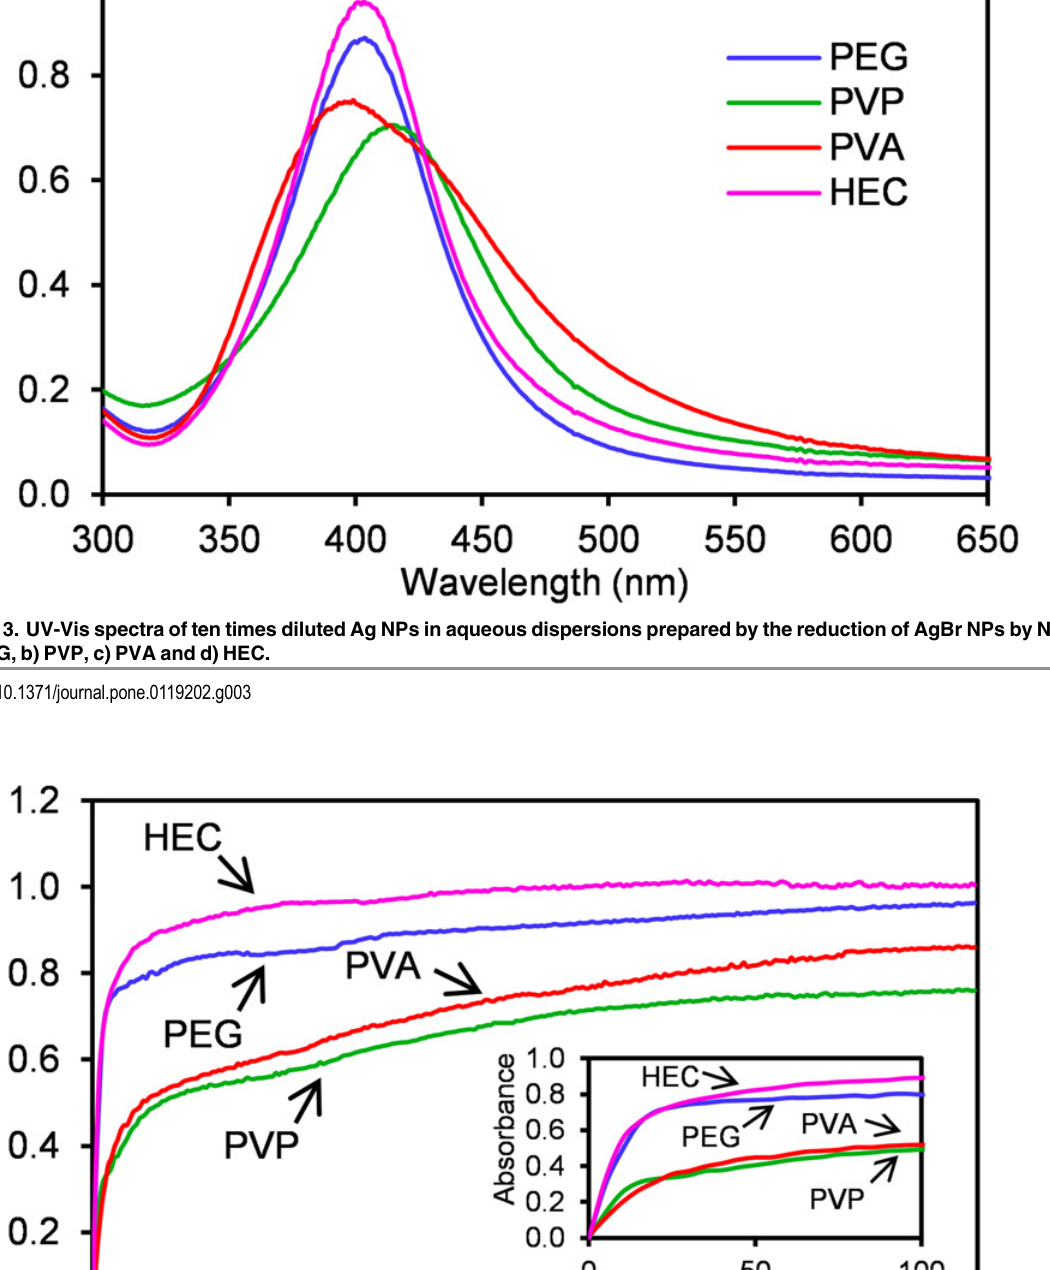
PLOS ONE | DOI:10.1371/journal.pone.0119202 March 17,